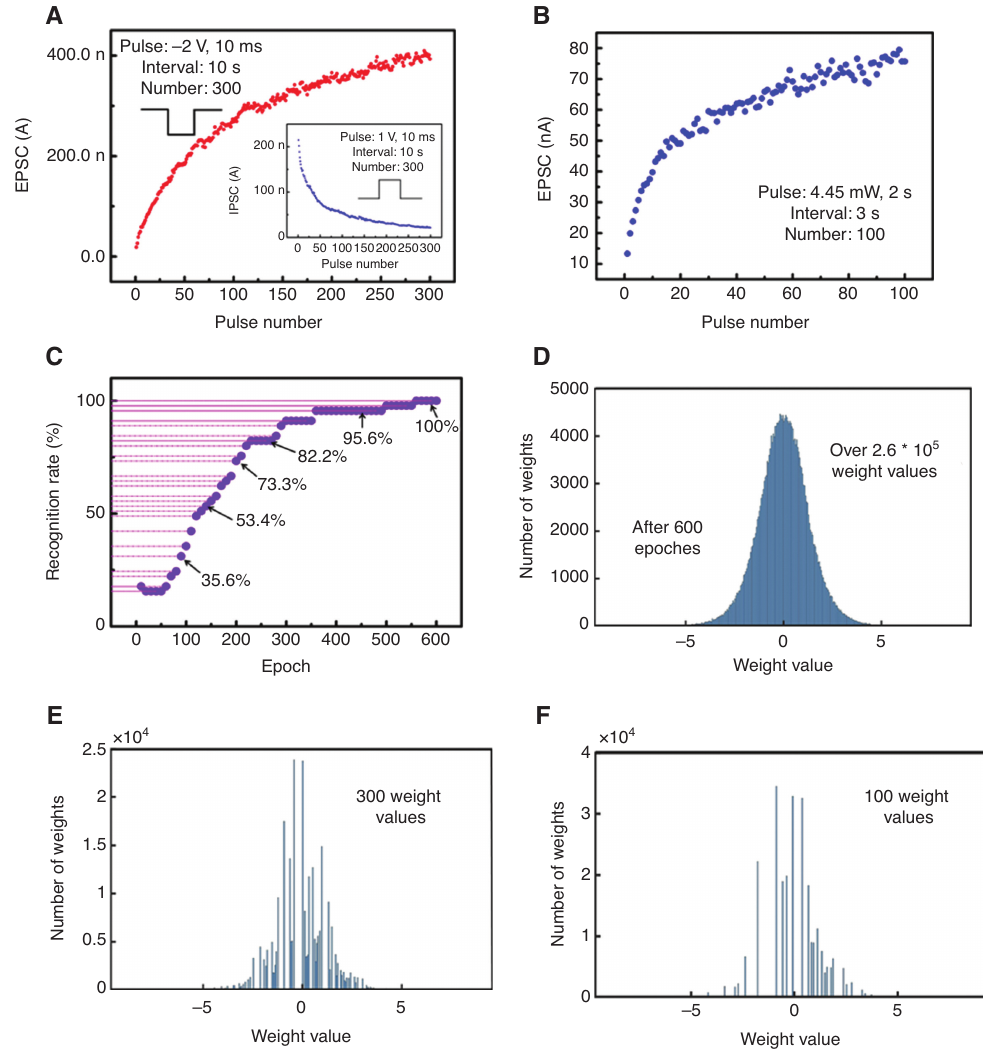
synaptic devices. Figure 6: Synaptic performance of the MoS 2 (A) Three hundred conductance states after 300 negative pulses were applied (−2 V, 10 ms, and 10-s interval). Inset: 300 conductance states after 300 positive pulses (1 V, 10 ms, and 10-s interval). (B) One hundred conductance states after 100 consecutive laser pulses were applied (4.45 mW, 2 s, and an interval of 3 s). (C) Recognition rate curve with increasing training–testing cycles. (D) The distribution of weight values after 600 training–testing cycles. (E) The distribution of weight values that are replaced by 300 device conductance values. (F) The distribution of weight values that are replaced by 100 device conductance